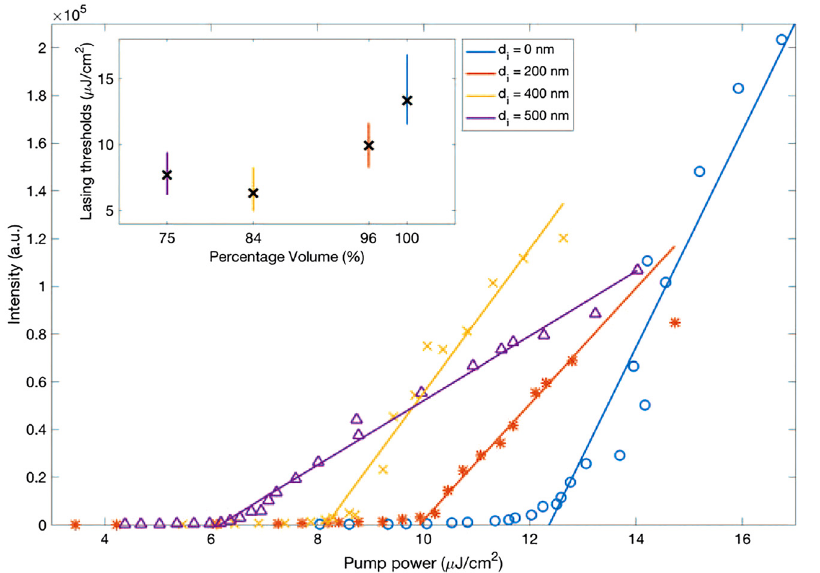
Figure 4: L – O curves for microrings with different inner diameter sizes (all had the same outer diameter length of 1 micron). Taken from the study by Wang et al. [35]. The inset shows average lasing thresholds (denoted by x ’ s) for the different-sized rings, each averaged over eight